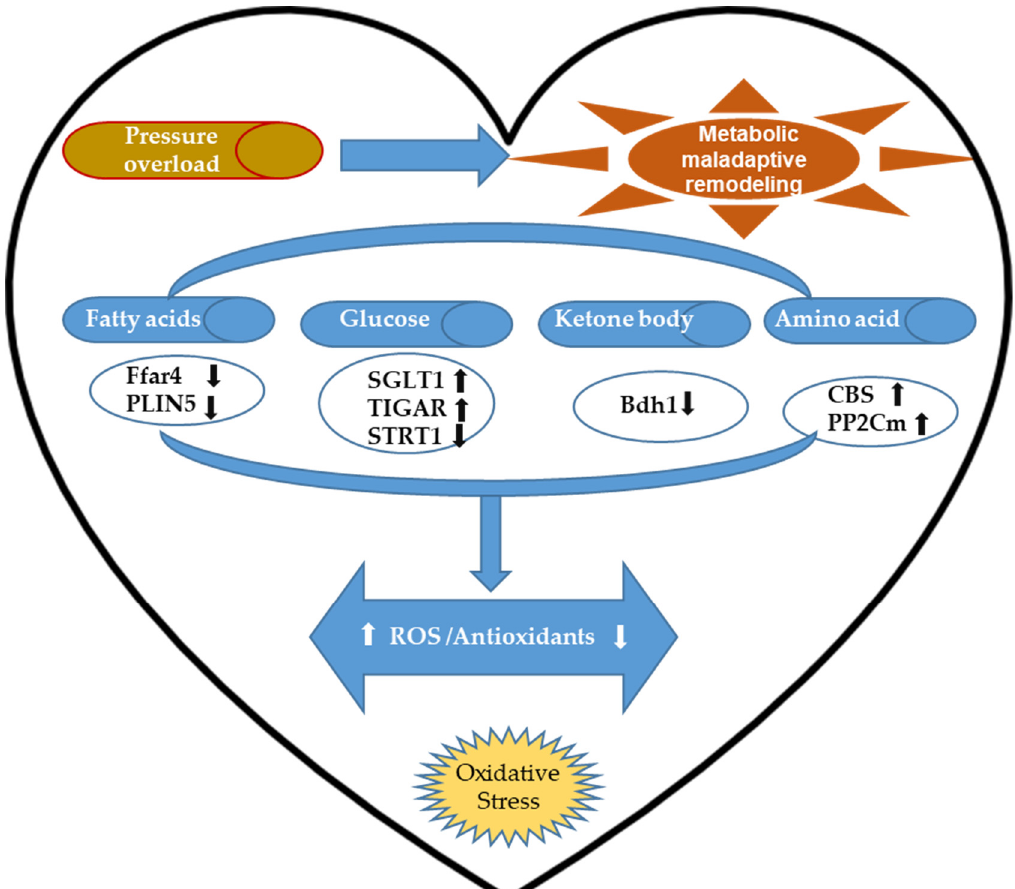
Figure 2. The updated potential regulation of metabolic remodeling on cardiac oxidative stress implicated in pressure-overload-induced cardiac injury. Cardiac oxidative stress induced by pressure overload is tightly associated with decreased mitochondrial oxidative capacity and maladaptive metabolic remodeling that shifts from predominantly using fatty acid oxidation to relying more on glucose, amino acids, and ketone metabolism under hypoxic conditions. Free fatty acid receptor 4 (Ffar4) deficiency attenuates excessive ROS production and multifaceted cardiac damage caused by stress overload, whereas perilipin 5 (PLIN5) deficiency does the opposite. Sodium-glucose cotransporter 1 (SGLT1) expression in pressure-overloaded hearts is positively correlated with increased oxidative and nitrosative stress. Moreover, cardiac-specific deletion of sirtuin 1 (Sirt1) promotes myocardial sensitivity to pressure-overload-induced cardiac damage. In contrast, TP53-induced glycolysis and apoptosis regulator (TIGAR) deficiency alleviates cardiac oxidative injury following pressure overload insult. 3-hydroxybutyrate dehydrogenase 1 (BDH1) overexpression reduces ROS production and enhances antioxidant expression in pressure-overloaded hearts while improving ketone utilization. Protein phosphatase 2C in mitochondria (PP2Cm) deficiency causes defective branched-chain amino acids (BCAA) catabolism and inhibits mitochondrial respiration accumulation of myocardial superoxides in the pressure-overloaded hearts. Cystathionine- β -synthase (CBS) deficiency lowers pressure-overload-induced plasma lipid peroxidation and reactive nitrogen species formation while improving plasma superoxide dismutase (SOD), glutathione (GSH), and glutathione peroxidase (GPx).